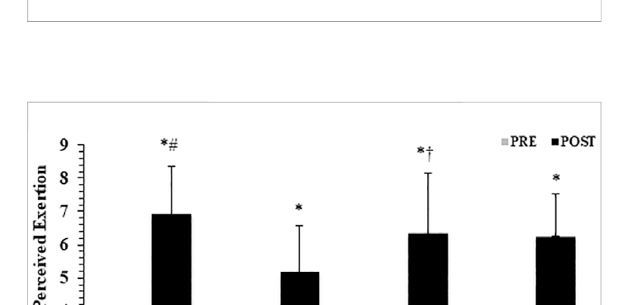
FIGURE 3 Average peak bar velocities (APV) in each experimental condition (CTRL: control, IPC: ischemic pre-conditioning, PAPE: post-activation performance enhancement, PAPE + IPC: combination of PAPE and IPC conditions). *: p < 0.05 from CTRL.